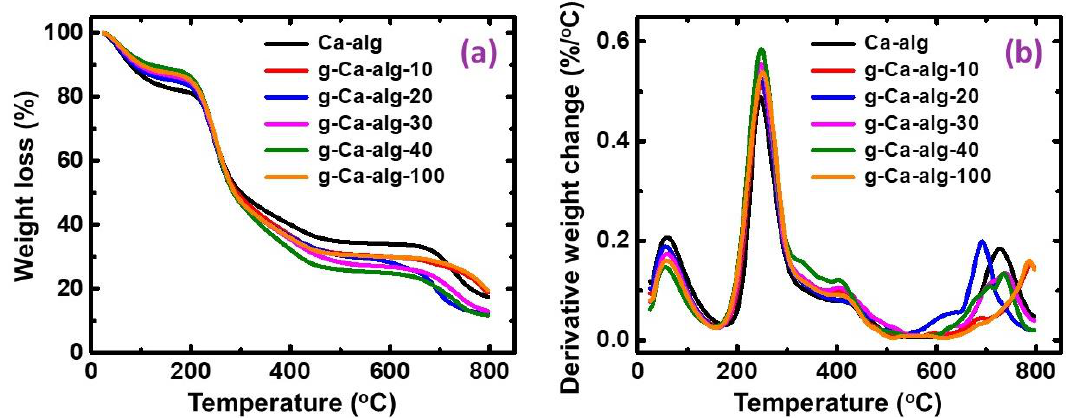
Figure 4. TGA ( a ) and DTG ( b ) curves for Ca-alginate and g-Ca-alginate (G41) aerogels with different LA/–OH molar ratios, as indicated.